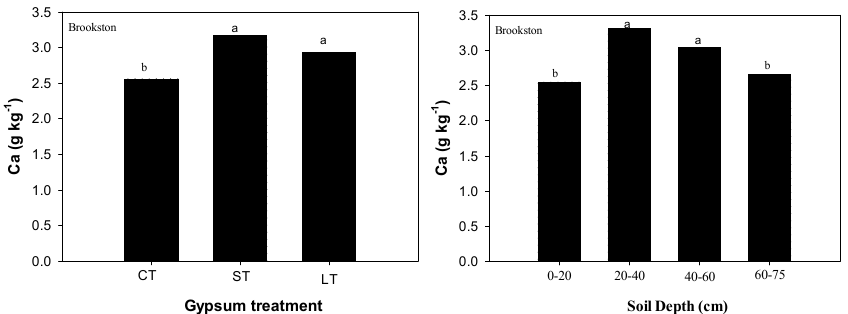
Figure 1. Calcium means values of Brookston soils in for each gypsum treatment ( left ) and in each soil layer ( right ). Means followed by the same letter or no letters for each soil and soil layer are not significantly different by Tukey’s test at p < 0.05.